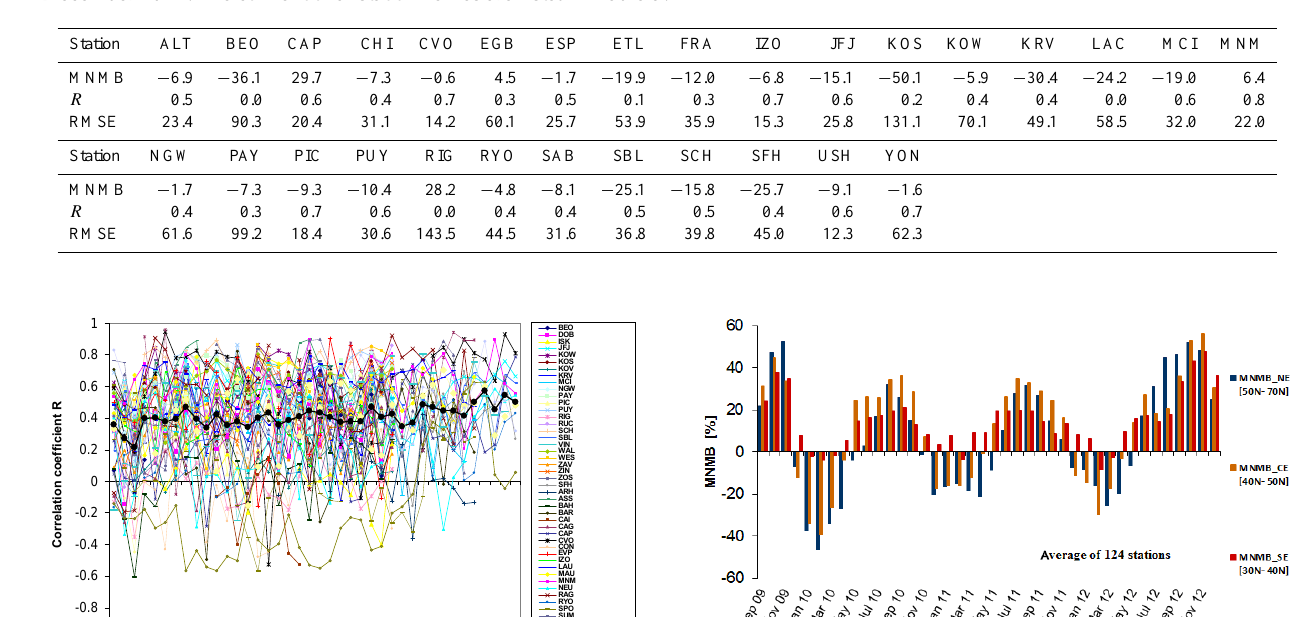
Table 5. Modified normalised mean bias (MNMB) [%], correlation coefficient ( R ), and root mean square error (RMSE) [ppb] derived from the evaluation of the MACC_osuite with Global Atmospheric Watch (GAW) CO surface observations during the period September 2009 to December 2012. The conventional station names are listed in Table 3.